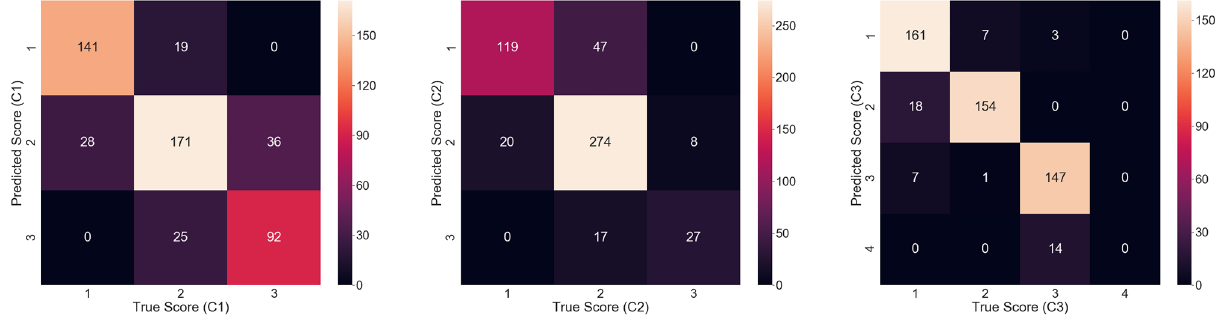
Figure 2. Confusion matrix showing the classification results for each